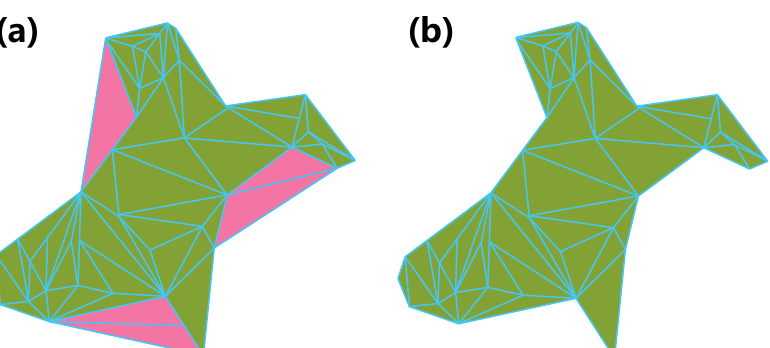
Figure 3. An analysis of the filtering effect of a triangular network: ( a ) represents the graph before filtering; ( b ) represents the graph after filtering.